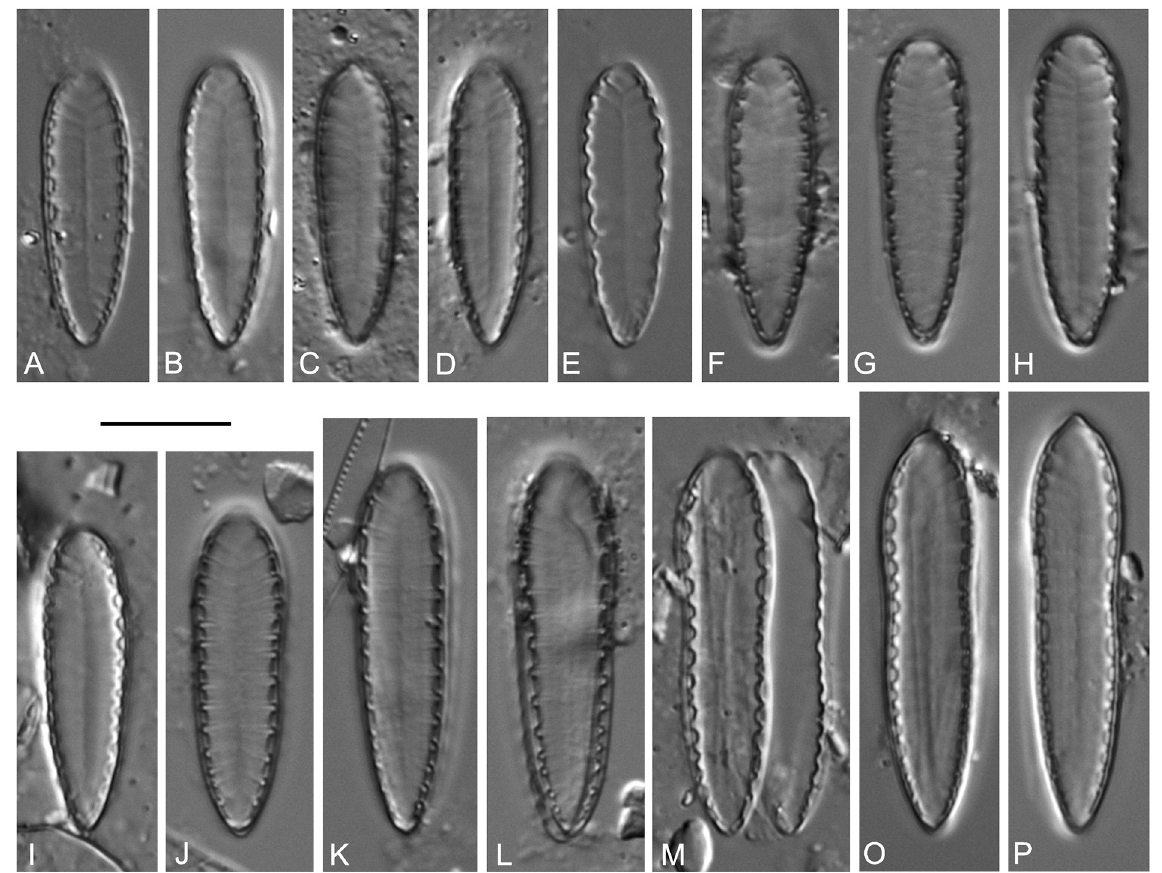
Fig. 6. Surirella congolensis sp. nov., from the holotype slide BR 4399, Lomami River, DR Congo, LM (DIC), valve views. G . Valve representing the holotype. Scale bar = 10 µm.